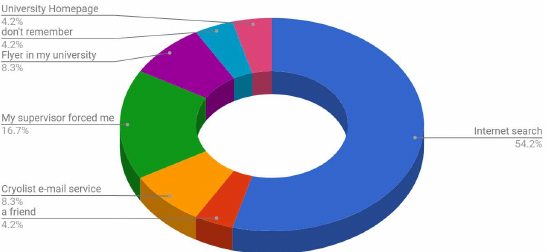
Figure 11. Break-down of how scholars learned about the summer school